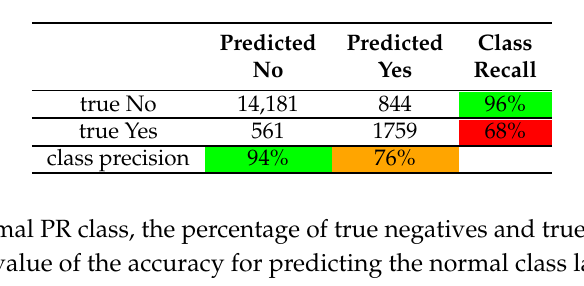
Table 7. Confusion matrix for DNN for Low